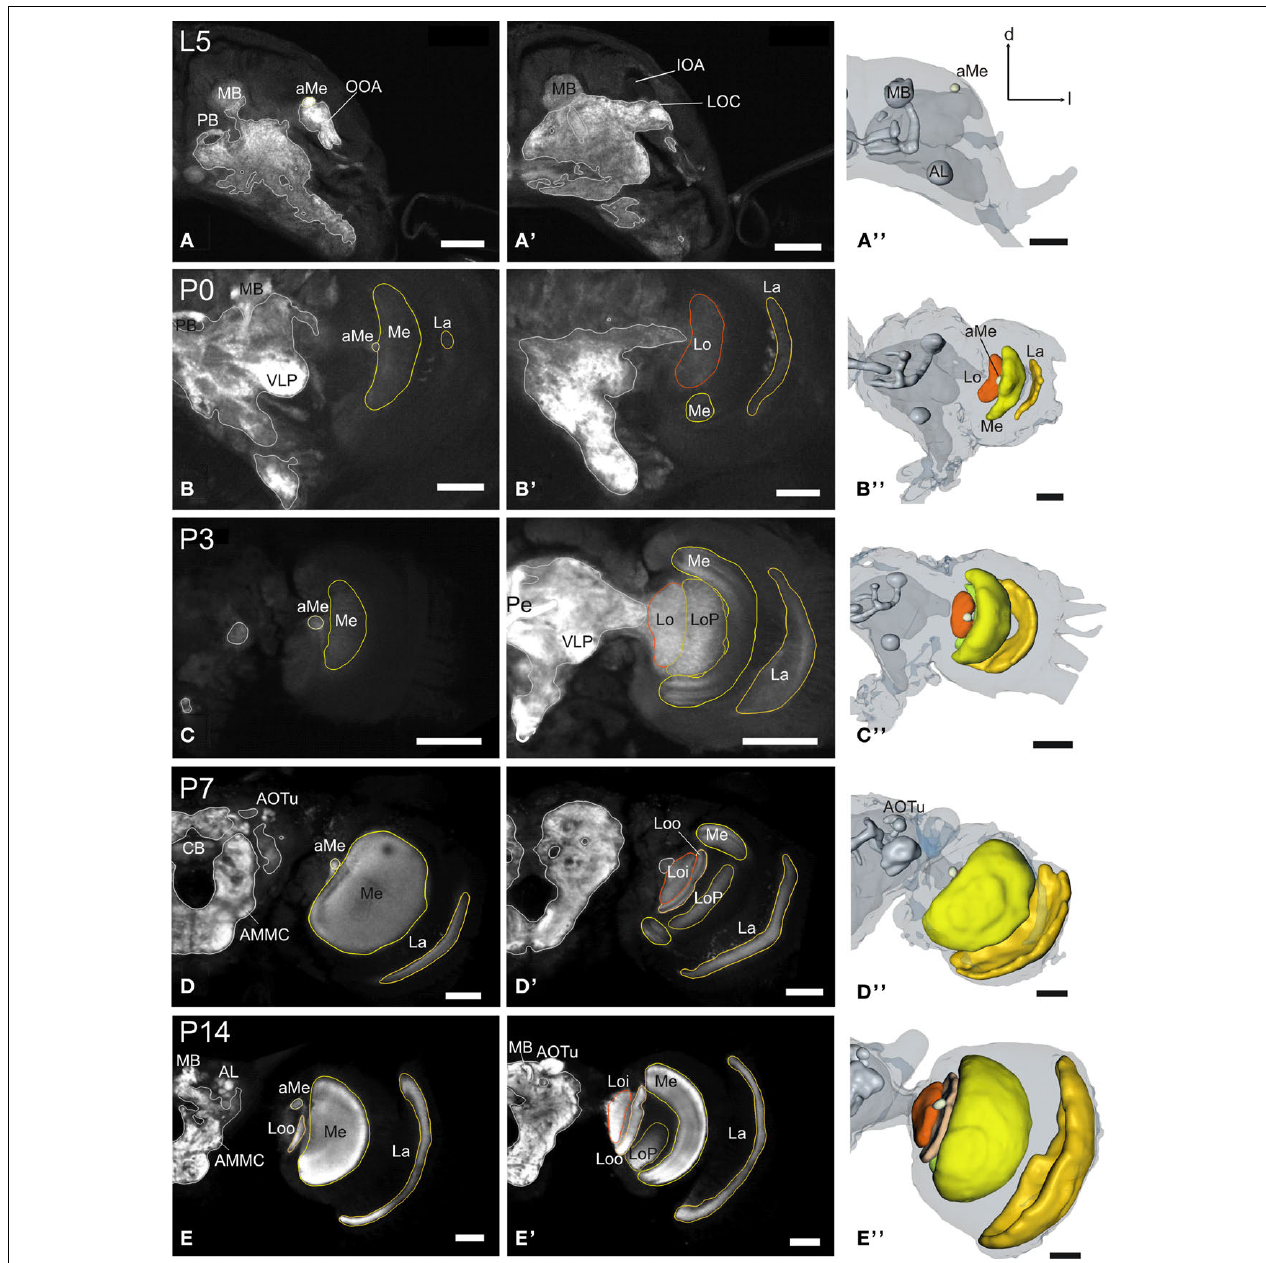
immunoreactivity in the ventrolateral protocerebrum (VLP). (C–C ′′ ) Stage P3: the La and Me further expand and the dorsal and ventral tips of the La bend behind the Me. The lobula plate (LoP) appears between Me and Lo. The anti- synapsin staining gains intensity in all neuropils; layers of the Me become recognizable. (D–D ′′ ) Stage P7: the inner and outer lobula (Loi, Loo) can be separated. The La starts to exhibit its bowl-like appearance, the opening still tilted towards the anterior side. (E–E ′′ ) Stage P14: all optic lobe neuropils reached their fi nal adult positions. Orientation bars: d, dorsal; l, lateral; scale bars: 100 µm (A–B ′′ ) ; 200 µm (C–E ′′ )